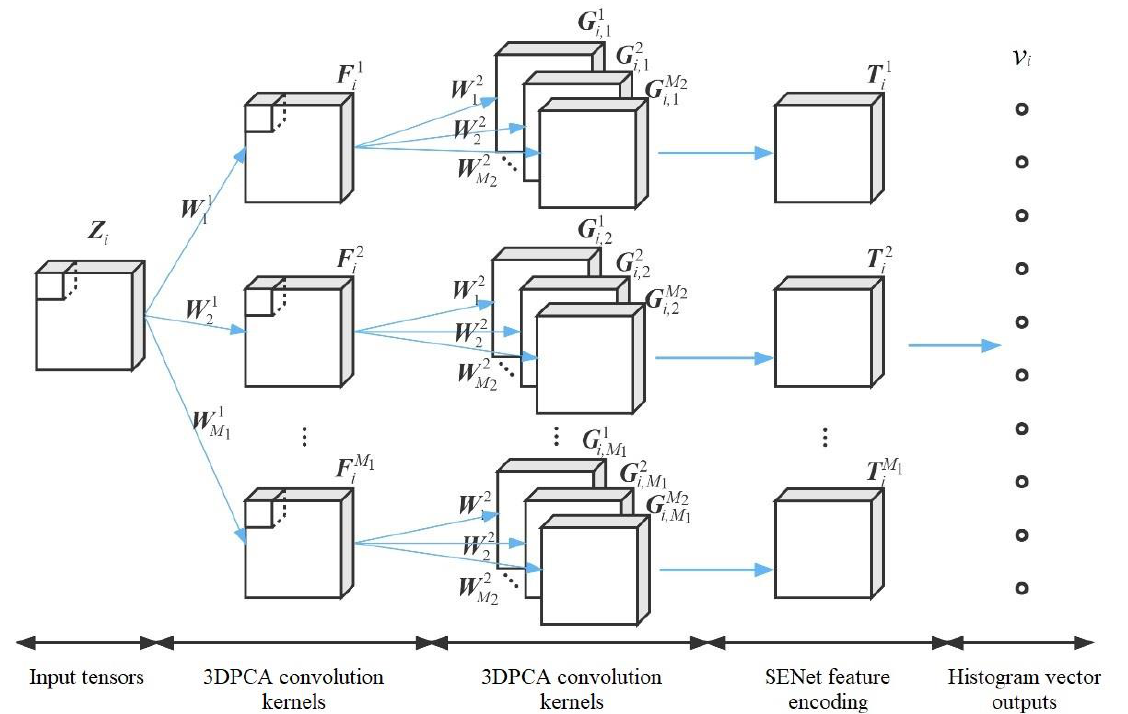
Figure 4. Schematic diagram of the SE-3DPCANet structure.